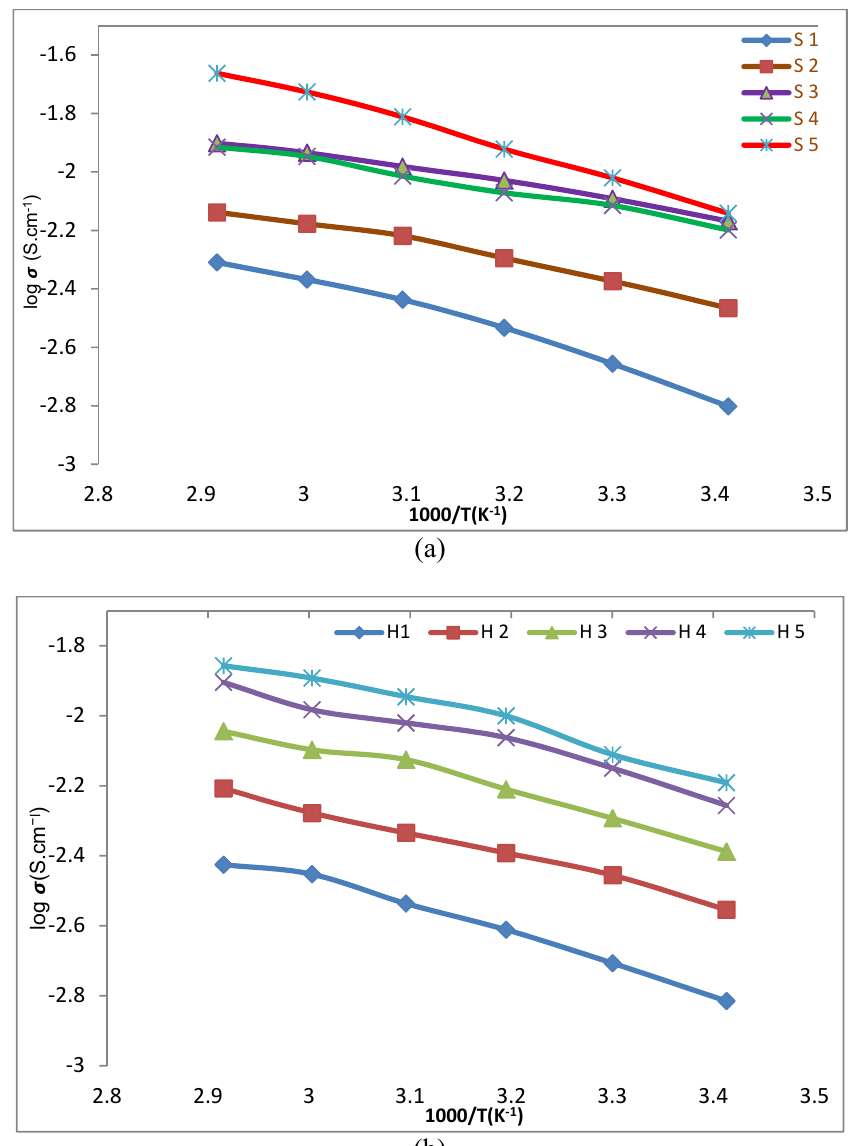
Fig. 1: Temperature dependence of the ionic conductivity of the gel polymer electrolytes (a) S and (b)